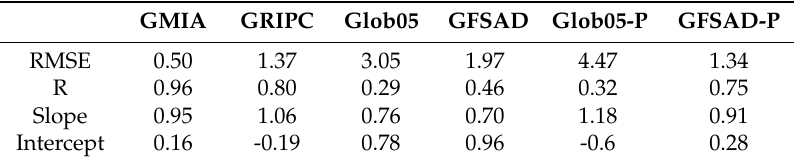
Table 2. RMSE, R, slopes and intercepts of regression